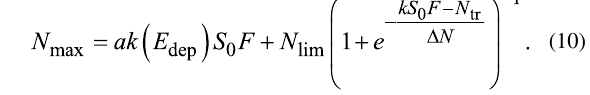
point. As shown in Figure 6, several large clusters containing more than 150 Pt atoms have been formed in the beam spot area in the present simulation at electron fluence of 8 × 10 18 cm − 2 .